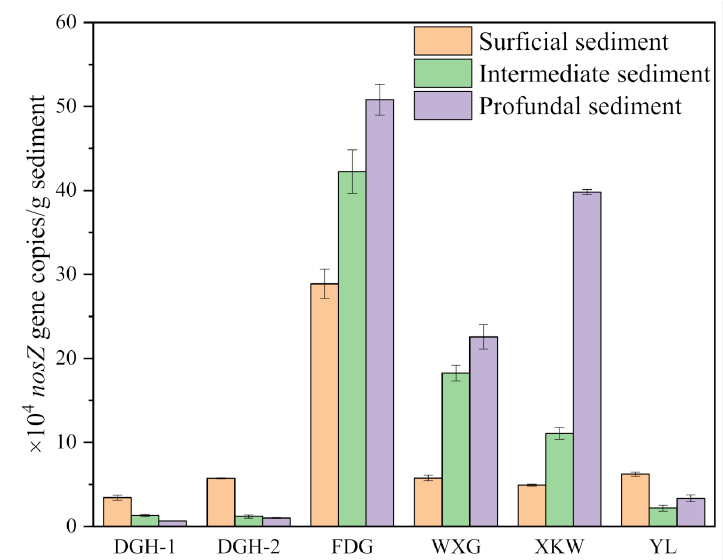
Figure 6. Average nosZ gene abundance in each sediment of different